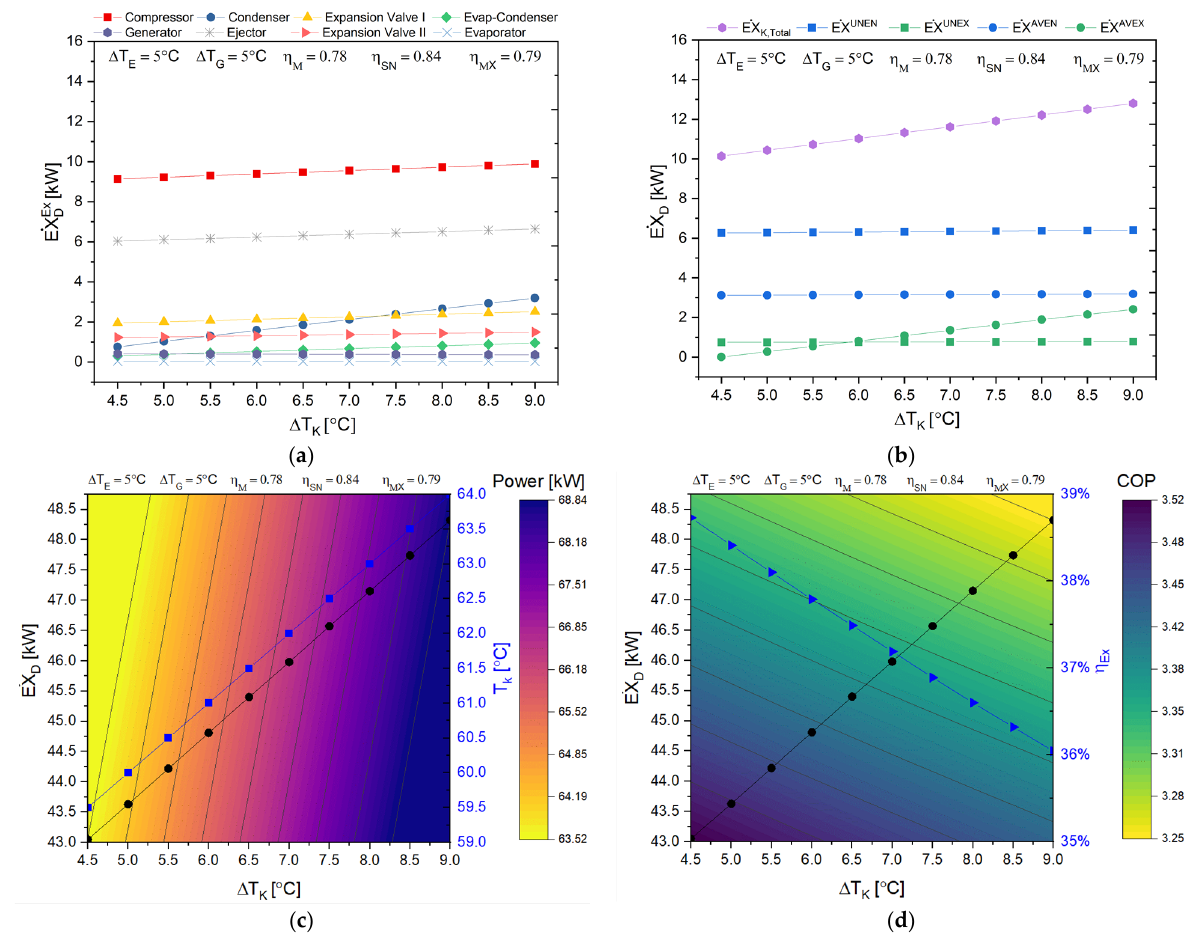
Figure 10. Condenser glide temperature variation influence: ( a ) components exergy exogenous part, ( b ) ejector exergy destruction parts, ( c ) refrigerant mass flow rate, and ( d ) system COP-exergy.